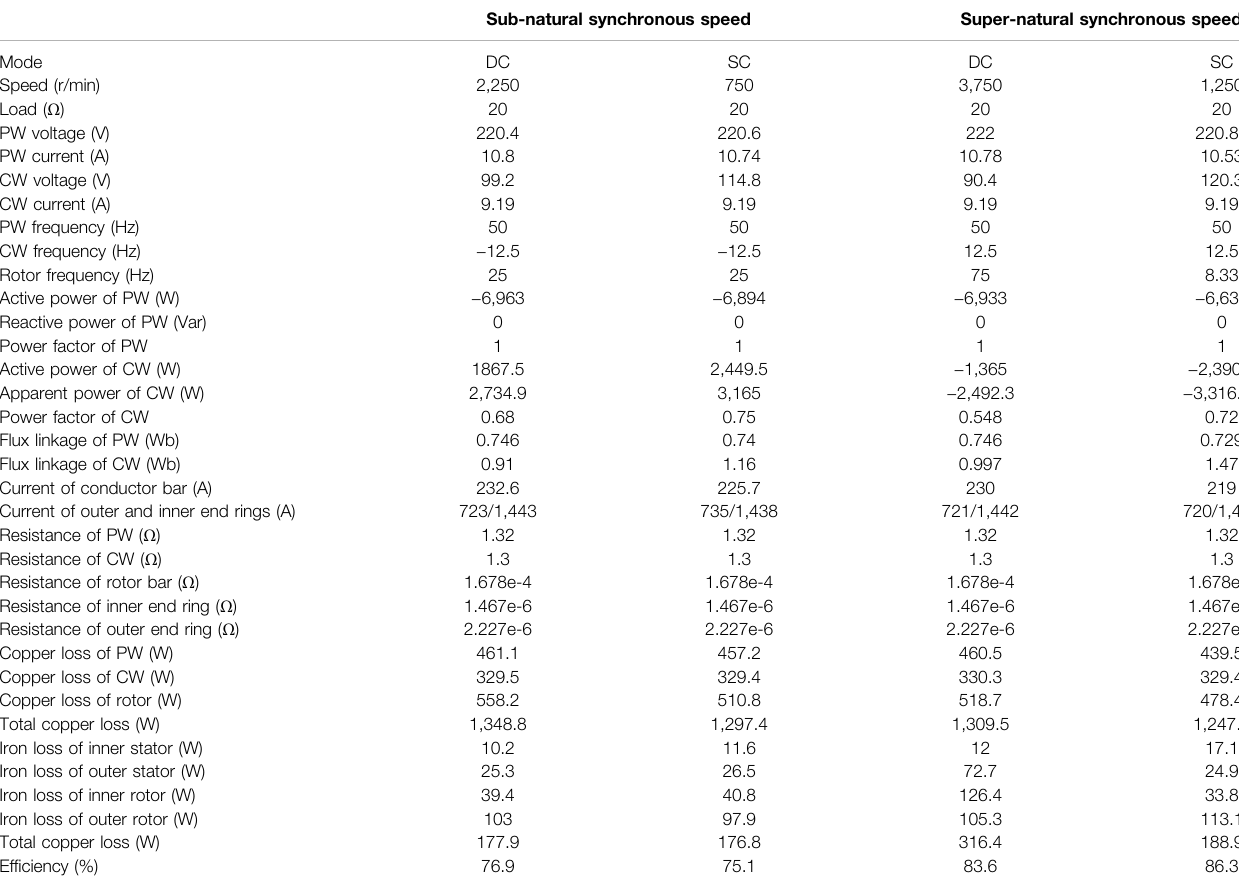
TABLE 4 | Performance comparison between DC and SC modes under rated sub-natural and super-natural synchronous speeds. Sub-natural synchronous